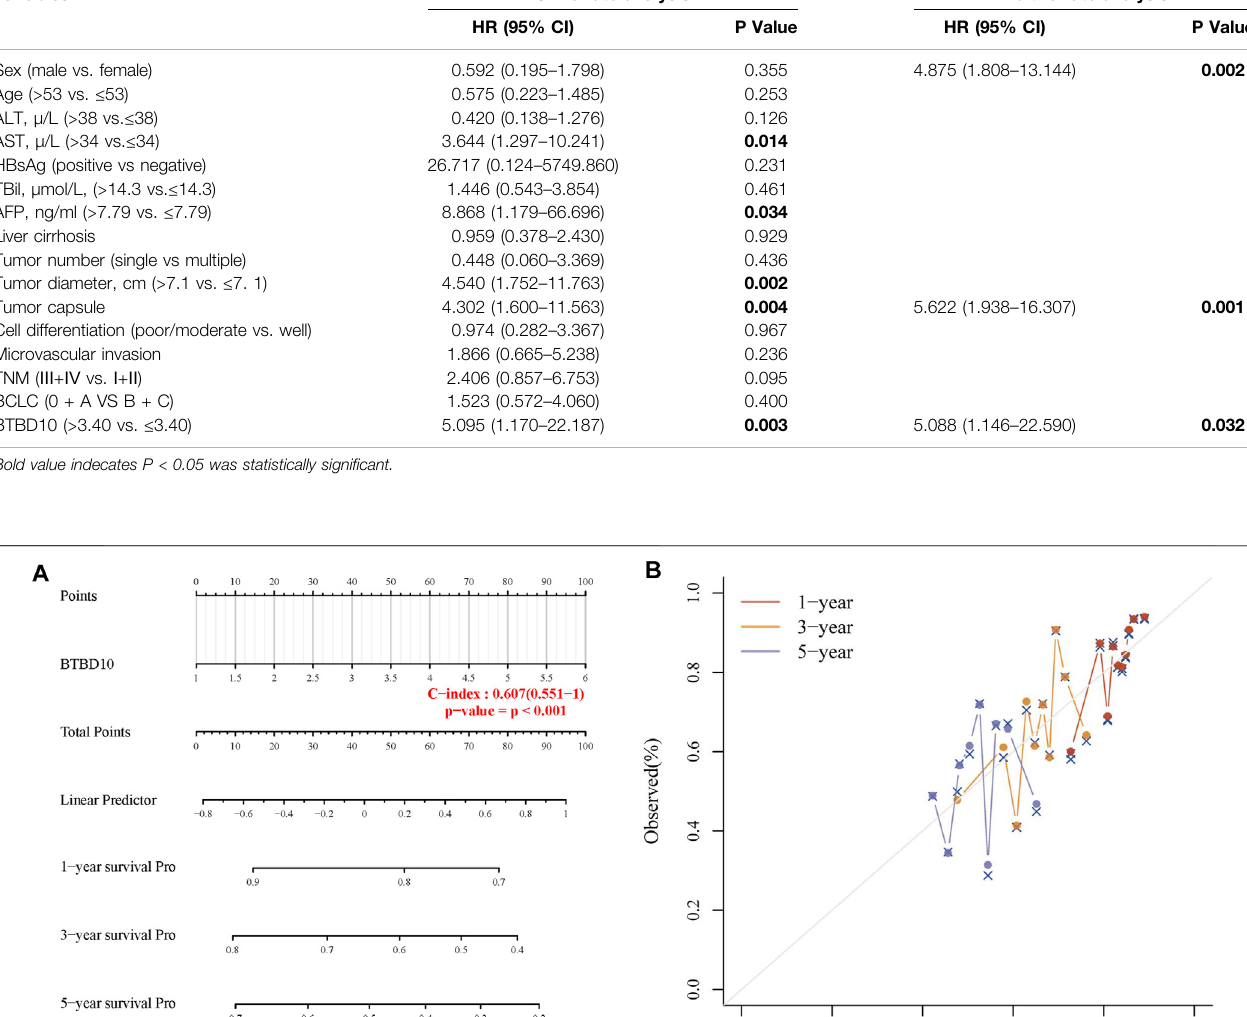
TABLE 3 | Xijing hospital data: Univariate and multivariate cox regression analyses of risk factors associated with overall survival. Variables